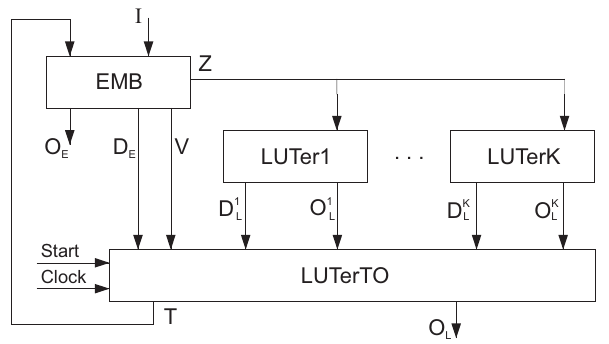
Figure 27. The structural diagram of PH Mealy